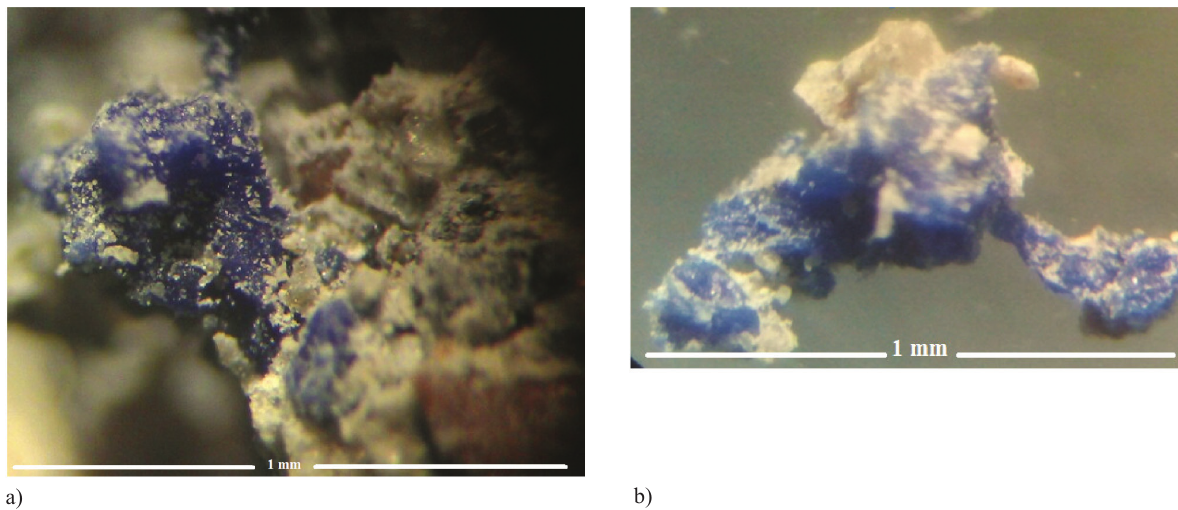
Fig. 10. contact zone between the cement matrix and an ecW particle (a) and an ecW particle of the size up to 1 mm